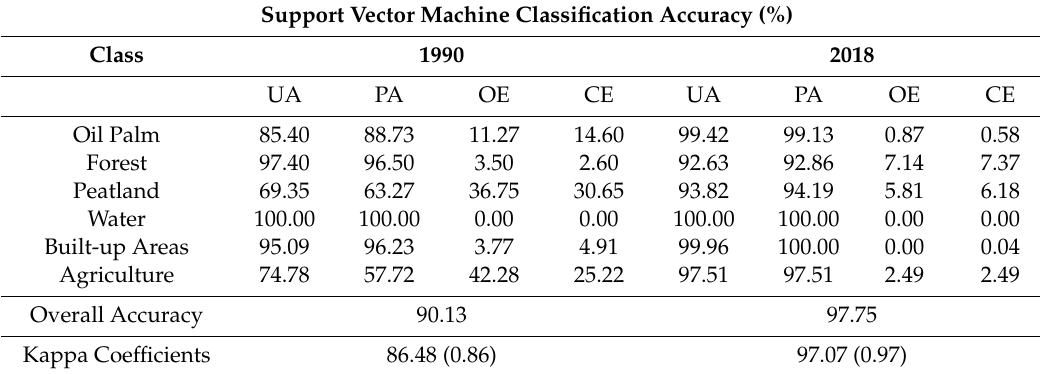
Table 3. Sarawak land use classification accuracy